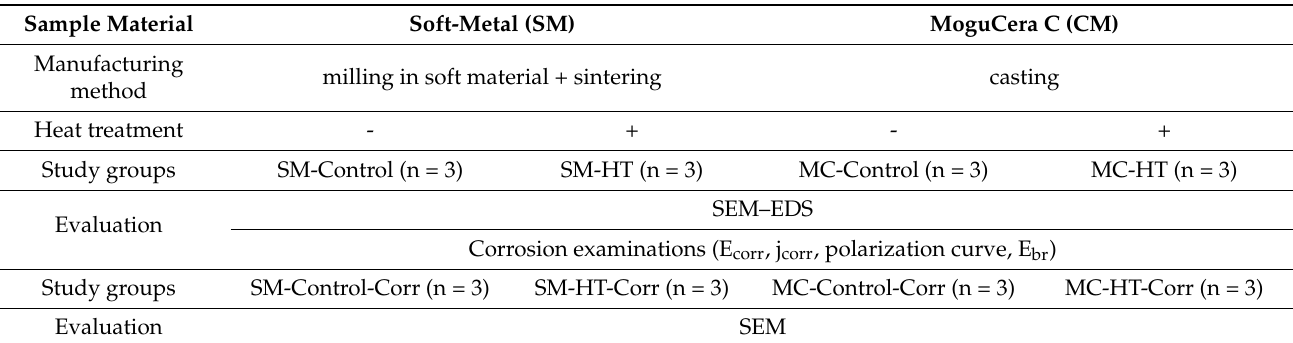
Table 2. Study design.